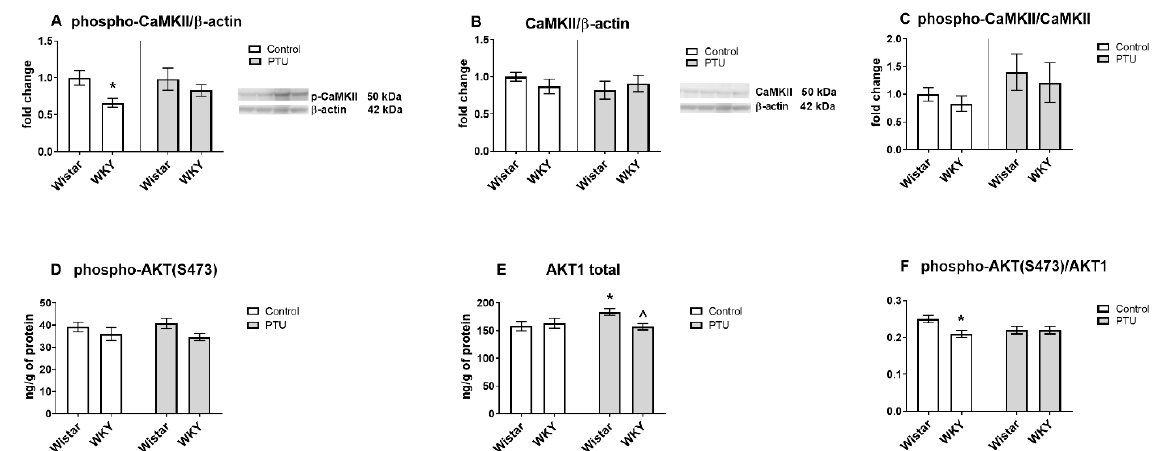
Figure 6. The effects of strain and PTU treatment on the protein levels of phospho-CaMKII ( A ), CaMKII ( B ), phospho- CaMKII/CaMKII ( C ), phospho(Ser473)-AKT1 ( D ), AKT1 ( E ) and phospho-AKT(S473)/AKT1 ( F ) in the hippocampus. The results are expressed as the average fold change ± SEM ( A – C ) or as the mean ± SEM ( D – F ). * p < 0.05 vs. the control group (Wistar rats); ^ vs. the Wistar PTU group. n = 8–10.